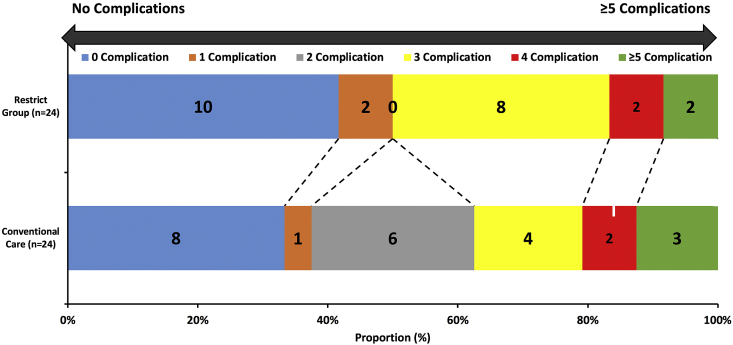
The distributions of participants across categories defined by number of complications per participant in the restrictive fluid therapy group (Restrict group) and Conventional care group.